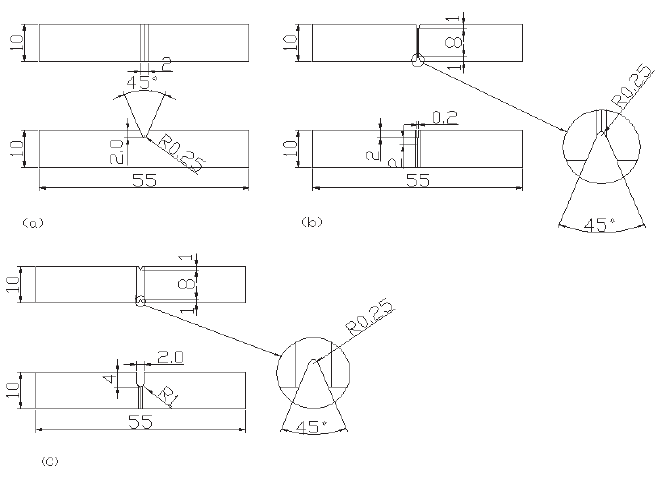
Fig.1. Confuguration of specimen (in mm) ; (a) V-notched specimen, (b) faigue pre-cracked specimen, (c) U-notched